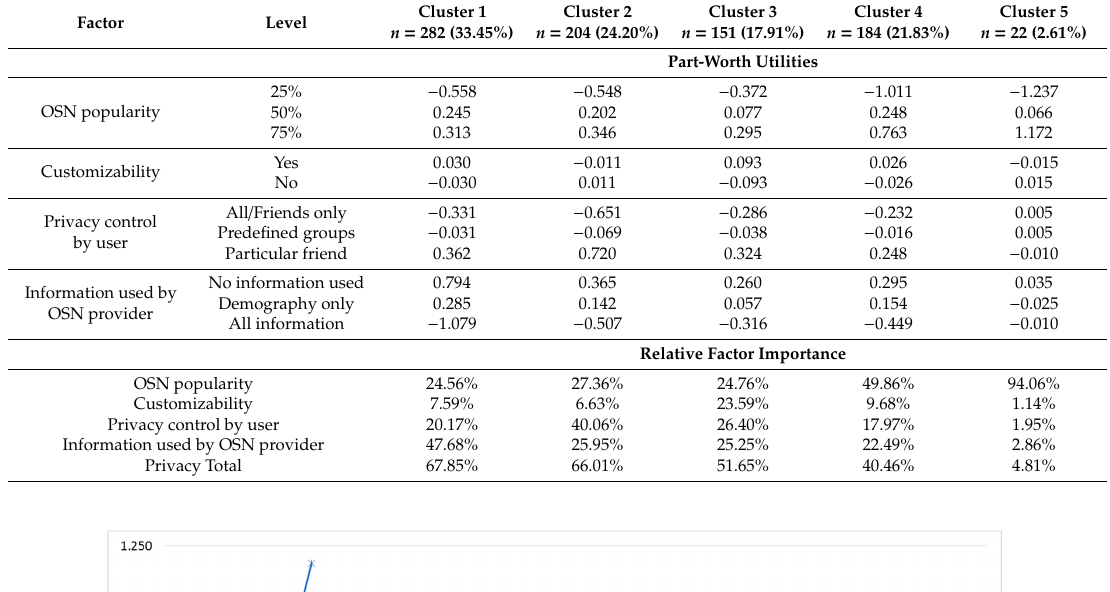
Table 4. Relative factor importance and part-worth utilities across clusters.